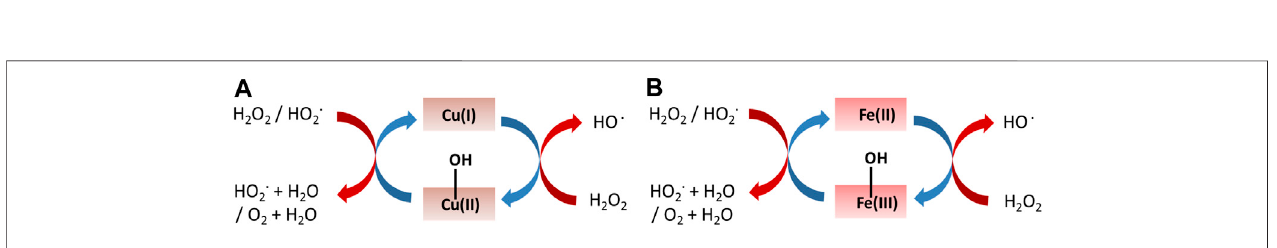
FIGURE 7 | Fenton reaction mechanism for Cu (A) and Fe (B)